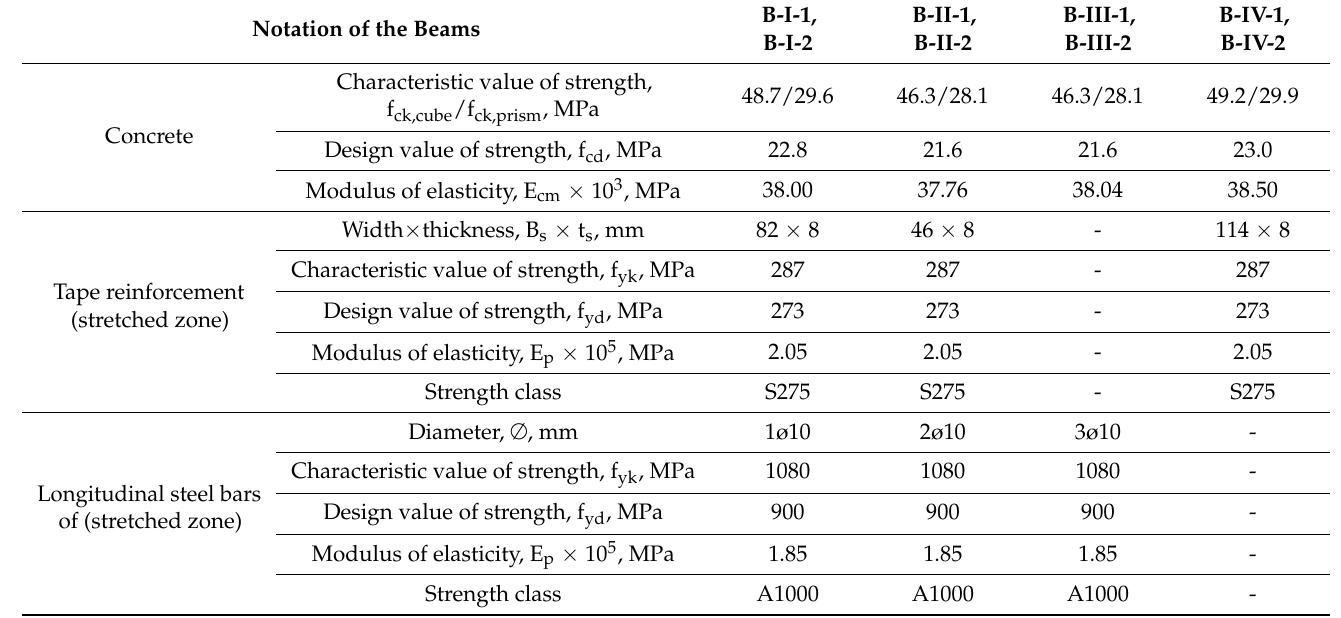
Table A2. Physical characteristics of materials of the experimental